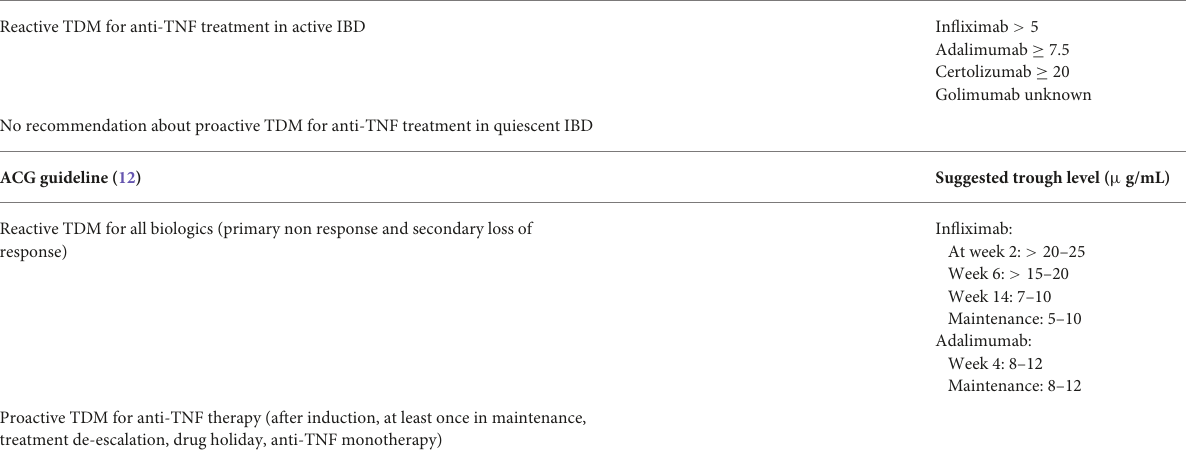
TABLE 1 Summary of AGA and ACG guidelines. AGA guideline (14) Suggested trough level ( µ g/mL) Reactive TDM for anti-TNF treatment in active IBD Infliximab > 5